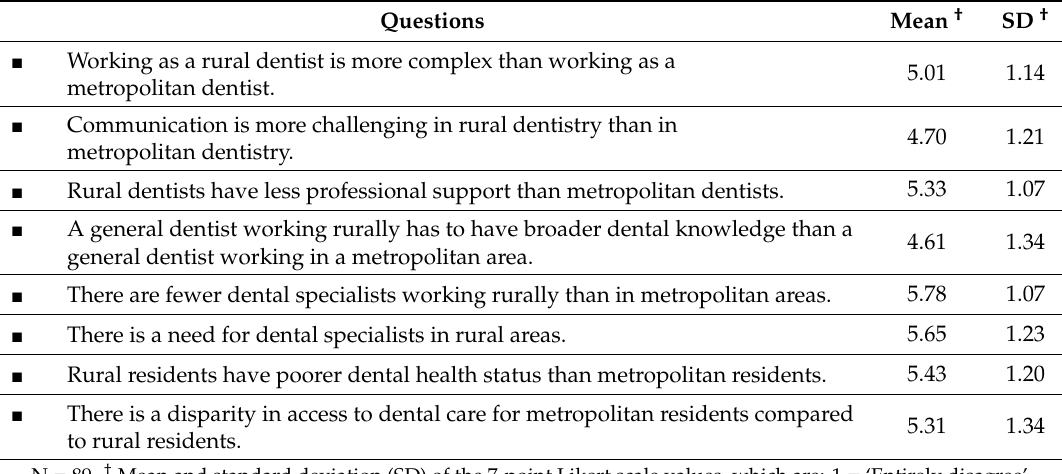
Table 2. First-year dental students’ perception of dental practice and oral health in rural areas.